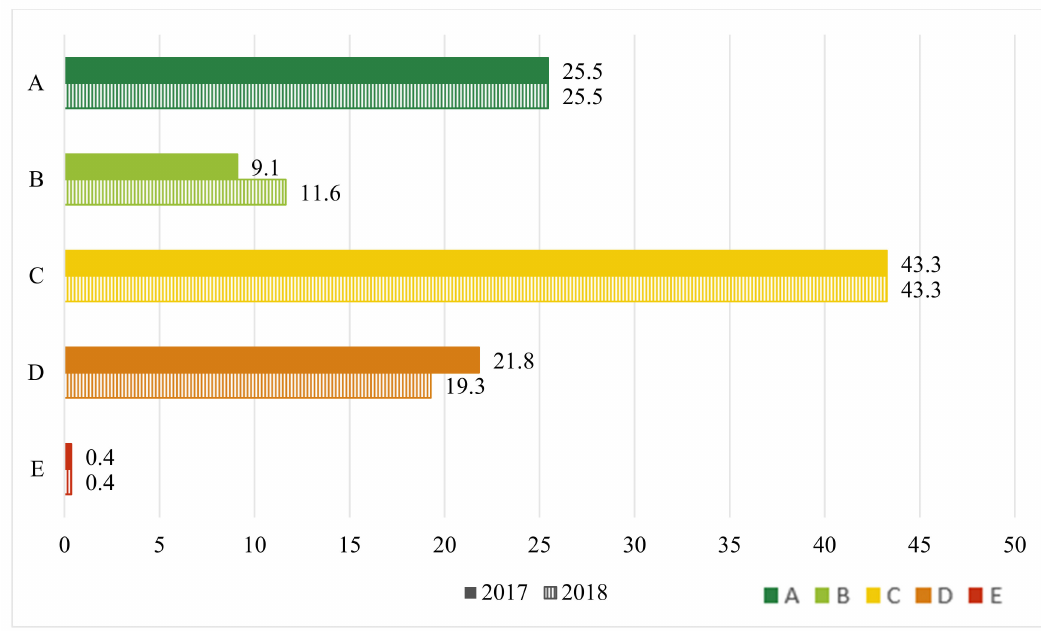
Figure 4. Nutri-Score allocation for breakfast cereals on the Belgian market in 2017 and